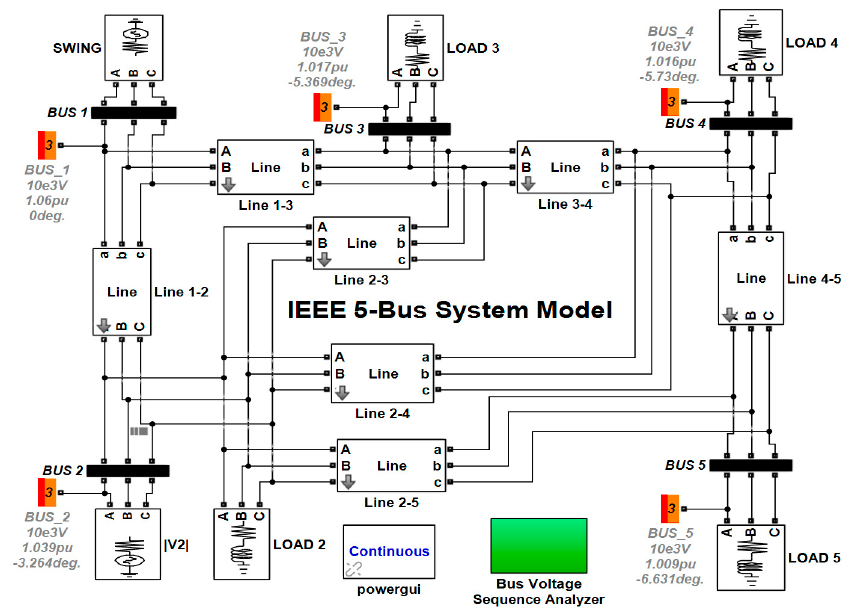
Figure 7. Simulated model of the IEEE 5 bus system.